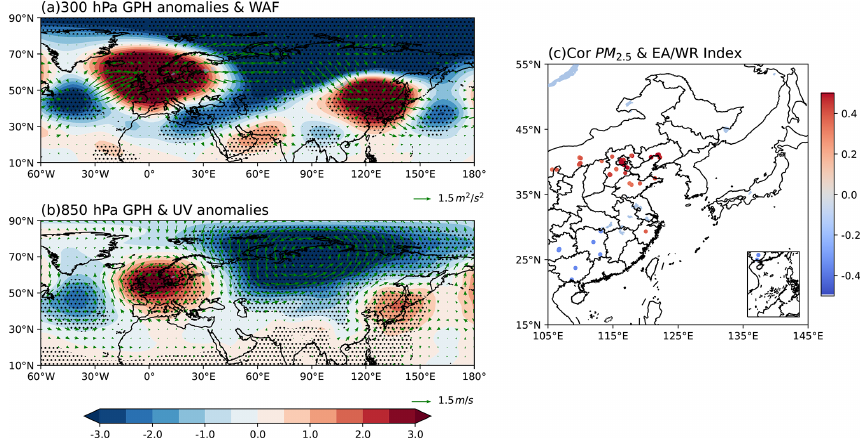
Figure 7. Composite anomalies of (a) GPH (shading, gpm) and WAF (vectors, m 2 s − 2 ) at 300hPa, and (b) GPH (shading, gpm) and horizontal wind (vectors, ms − 1 ) at 850hPa for Type2. Dotted areas are statistically significant at the 95% confidence level. (c) Correlation coefficients between Type2 PM 2 . 5 concentrations and the EA/WR